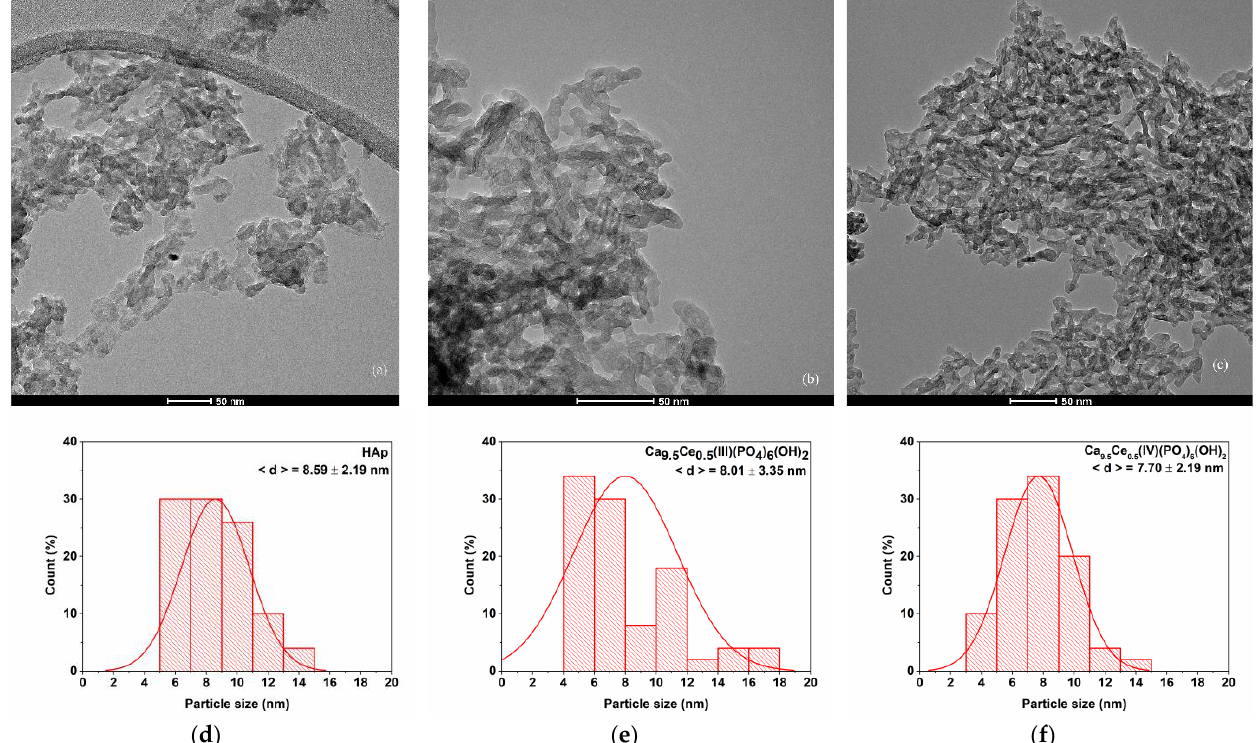
Figure 6. The TEM image of ( a ) pure HAp; ( b ) Ca 9.5 Ce(III) 0.5 (PO 4 ) 6 (OH) 2 and ( c ) Ca 9.5 Ce(IV) 0.5 (PO 4 ) 6 (OH) 2 . Particle size distribution of obtained materials for ( d ) pure HAp; ( e ) Ca 9.5 Ce(III) 0.5 (PO 4 ) 6 (OH) 2 and ( f ) Ca 9.5 Ce(IV) 0.5 (PO 4 ) 6 (OH) 2